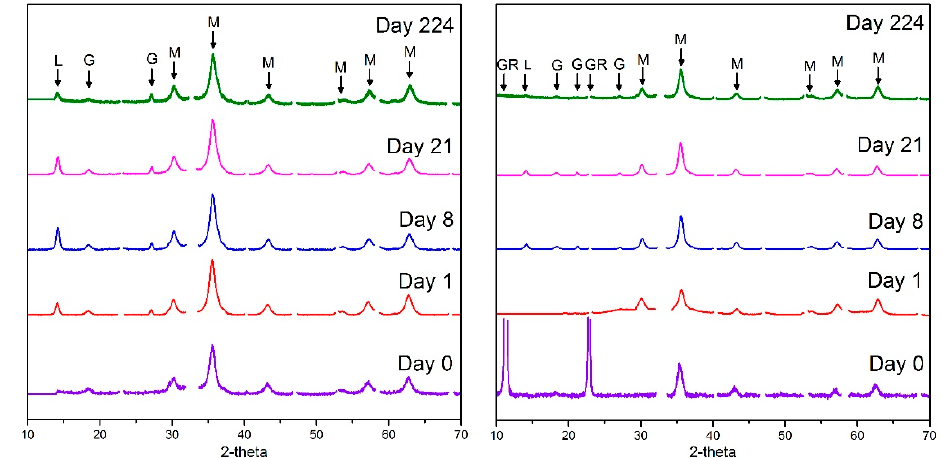
Figure 1. X-ray diffraction (XRD) pattern time series for Fe(II)/Fe(III) = 0.6 and Fe(II)/Fe(III) = 2.0 over a period of oxidation in air from time 0 (freshly co-precipitated) to 224 days. Observable peaks are indexed with GR, M, L or G indicating green rust, magnetite, lepidocrocite or goethite, respectively. To further define the speciation of neptunium in the co-precipitated mineral phases upon their formation and subsequent oxidation, neptunium L 3 edge XANES and EXAFS spectra were collected on the solid phase samples at the reduction and oxidation endpoints. The Np concentration on the solids was between 30 and 300 ppm. In the magnetite system we worked with dilute (tens of ppm) concentrations of Np to start to explore the limits of XAS analyses, both to reach into more environmentally relevant concentrations and to reduce radiotoxicity in experiments. Samples analysed included co-precipitated magnetite (30 and 300 ppm), co-precipitated green rust (300 ppm), end-point oxidised magnetite (300 ppm, 224 days oxidation) and end-point oxidised green rust (300 ppm, 224 days oxidation).